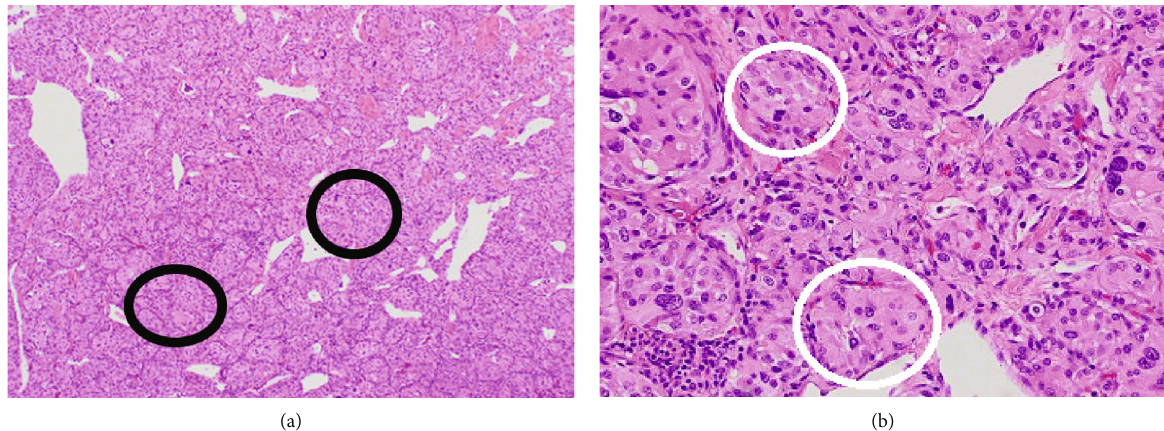
Figure 3: (a) Cardiac paraganglioma histology. Multiple large groups of characteristic Zellballen morphology (in black circles) with nests of uniform, polygonal chroma ffi n/chief cells surrounded by sustentacular support cells and well-formed vascular cu ffi ng. (b) Cardiac paraganglioma histology. Characteristic Zellballen morphology (white circles) with nests of uniform, polygonal chroma ffi n/chief cells surrounded by sustentacular support cells and well-formed vascular cu ffi ng.